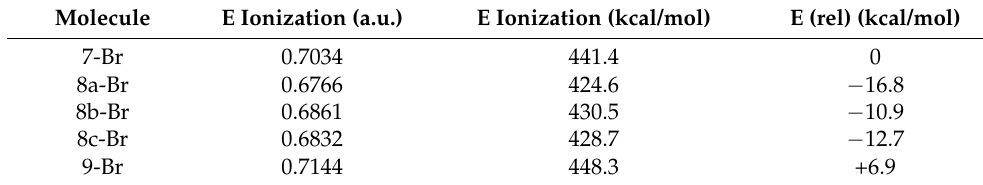
Table 1. Ionization energies of select allyl- and dienyl bromides 1 .